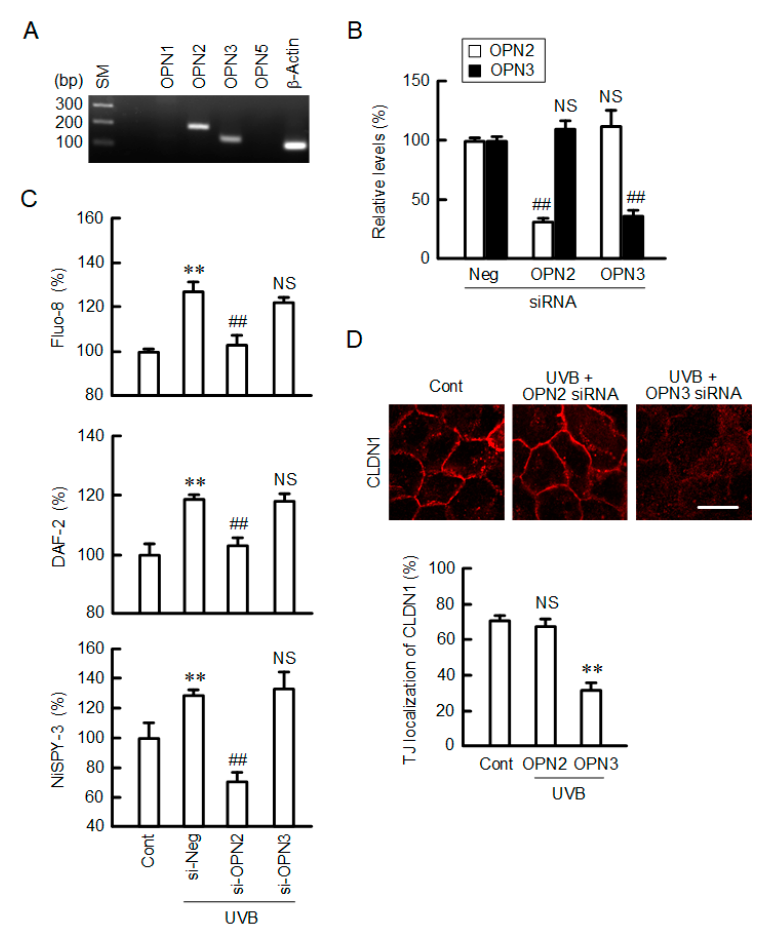
Figure 9. Involvement of OPN2 in the UVB-induced production of RNS. ( A ) PCR was performed using primer pairs against OPN1-3 and 5, as well as β -actin. The PCR products were visualized after electrophoresis on 2% agarose gel. Size marker (SM) was loaded on the left lane. n = 3. ( B ) The cells were transfected with negative (si-Neg), OPN2, or OPN3 siRNA and cultured for 3 days. The expression levels of OPN2 and OPN3 mRNAs were measured using real-time PCR. n = 4. ( C ) The cells transfected with si-Neg, OPN2, or OPN3 siRNA were exposed to weak UVB. After 3 h, the cells were incubated with 5 µ M Fluo-8 AM, 5 µ M DAF-2DA, or 5 µ M NiSPY-3 for 30 min. The fluorescence intensities of Fluo-8, DAF-2, and NiSPY-3 were measured using a plate reader. n = 6. ( D ) The cells transfected with si-Neg, OPN2, or OPN3 siRNA were exposed to weak UVB. The cells were immunostained with anti-CLDN1 antibody. Scale bar indicates 10 µ m. The fluorescence values of CLDN1 at the TJ are shown as a percentage of the total fluorescence values. n = 5. ** p < 0.01 vs. Cont. ## p < 0.01 and NS p > 0.05 vs. si-Neg.